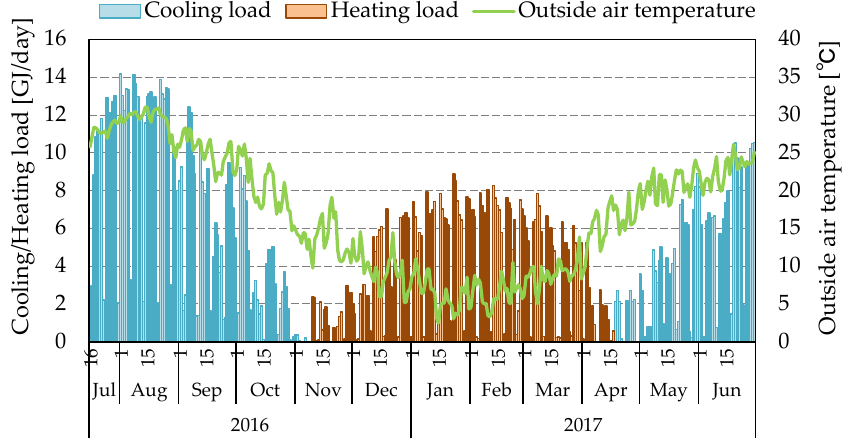
Figure 8. The cooling load and heating load and the outside air temperature of the building. The accuracy of the heat source model was verified using the measured values from 4 July to 6 2016. Figure 9 shows the accuracy verification results. In the figure, one point represents one hour. The heat source model calculates the COP using the power correction coefficient in Equation (2). The RMSE before power correction was 1.37, and after power correction, it was 0.62, which was improved by power correction.